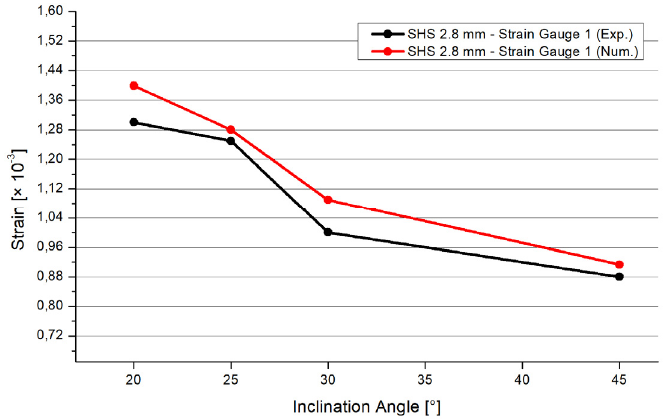
Figure 8. Total deformation for 20° model.